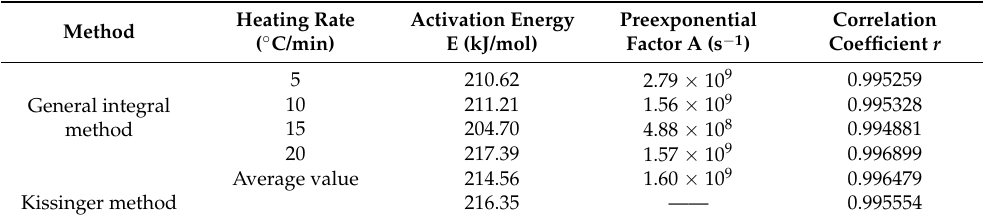
Table 4. Kinetic results for the decarburization reaction of CSK.